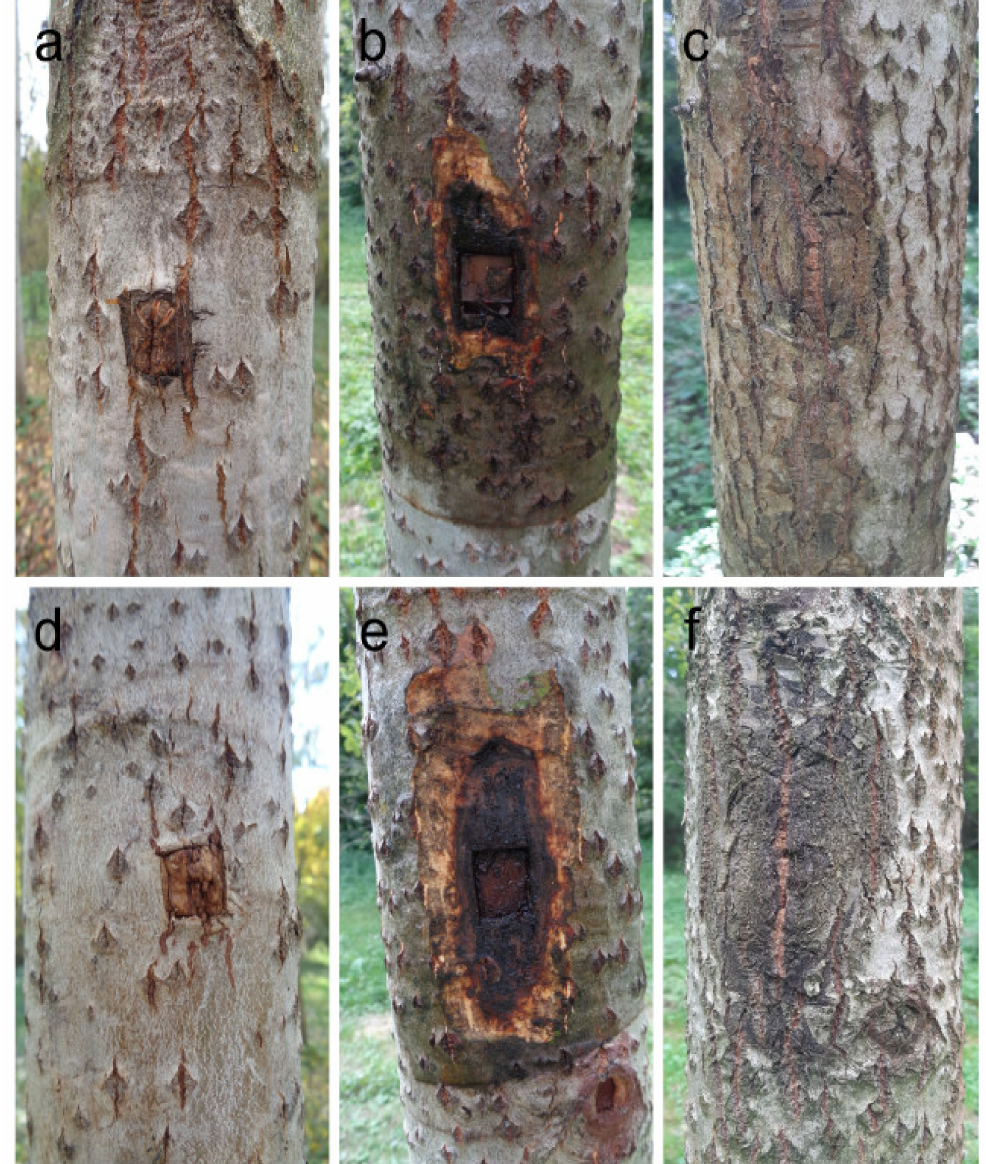
Figure 1. Symptoms caused by the Phytophthora cactorum isolate SFB057 ( b , c ) and the Phytophthora plurivora isolate SFB182 ( e , f ) on hybrid poplar stems following underbark inoculation test at breast height. ( a , d ) Controls showing the callus tissue which completely covered the wound sites. ( b , e ) Open bark cankers with necrotised bark tissues around the inoculation sites. ( c , f ) Bark cankers closed by the callus tissue four years following